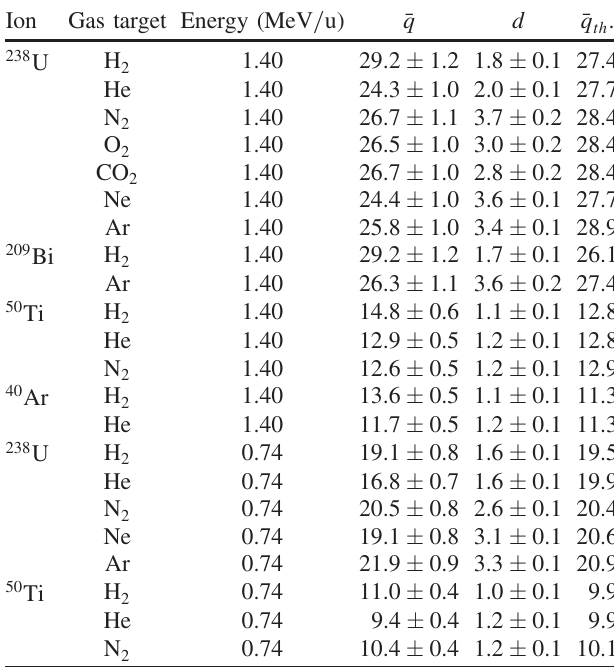
TABLE I. Mean charge states ¯ q and distribution widths d , obtained from the measurement data, and the calculated mean charge state ¯ q th . using the Schiwietz formula, as described in the text, for all ion-target combinations for which a charge state equilibrium was